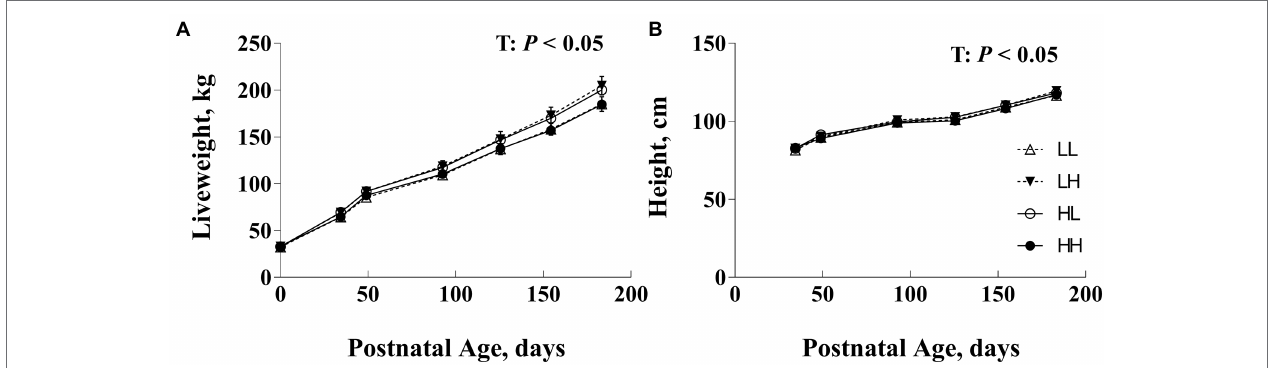
FIGURE 1 | Postnatal body weight (BW; A ) and hip height (B) of bulls following exposure to maternal diets low (L) and/or high (H) in protein during the peri- conception (PERI: − 60–23 dpc) and first trimester (POST; 24–98 dpc) periods of gestation 1 . T, time effects ( p < 0.05). No significant differences between maternal diet groups overall or among groups within age ( p > 0.05). 1 LL, Low protein maternal diet during both PERI and POST diet periods. LH, Low protein maternal diet during PERI and High protein during POST diet periods. HL, High protein maternal diet during PERI and Low protein during POST diet periods. HH, High protein maternal during both PERI and POST diet